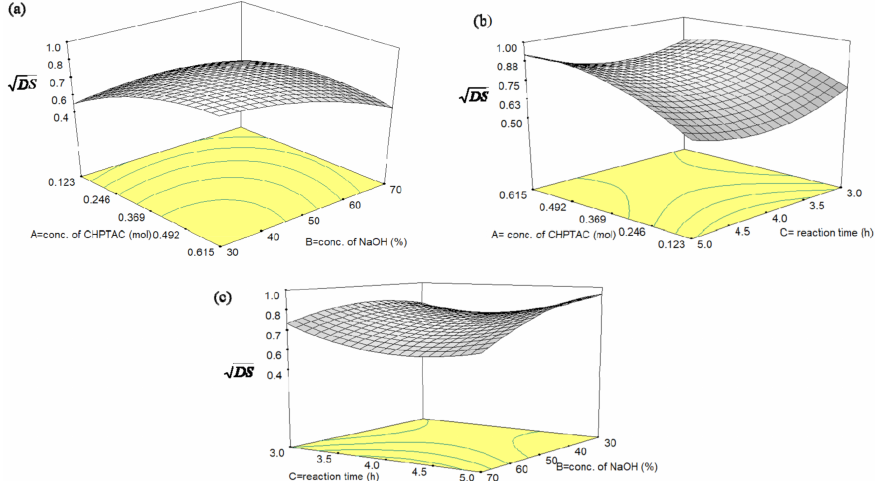
Figure 3. Response surface curve for effects of ( a ) CHPTAC conc. (mol) and NaOH conc. (%), ( b ) CHPTAC conc. (mol) and reaction time (h), ( c ) NaOH conc. (%) and reaction time (h) on the value of